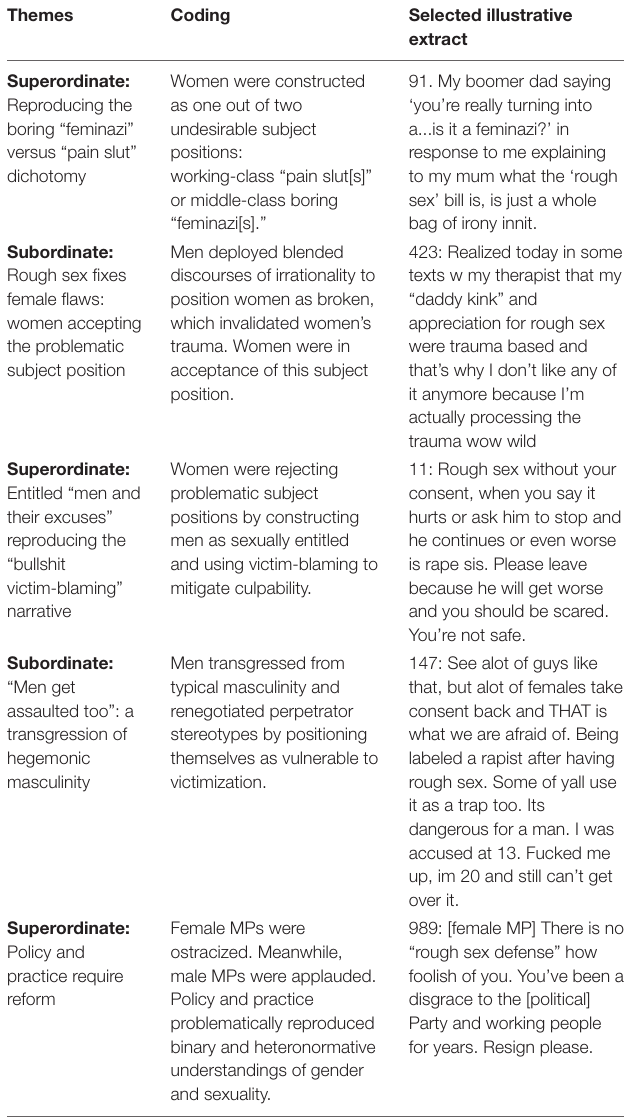
TABLE 1 | Coded superordinate and subordinate